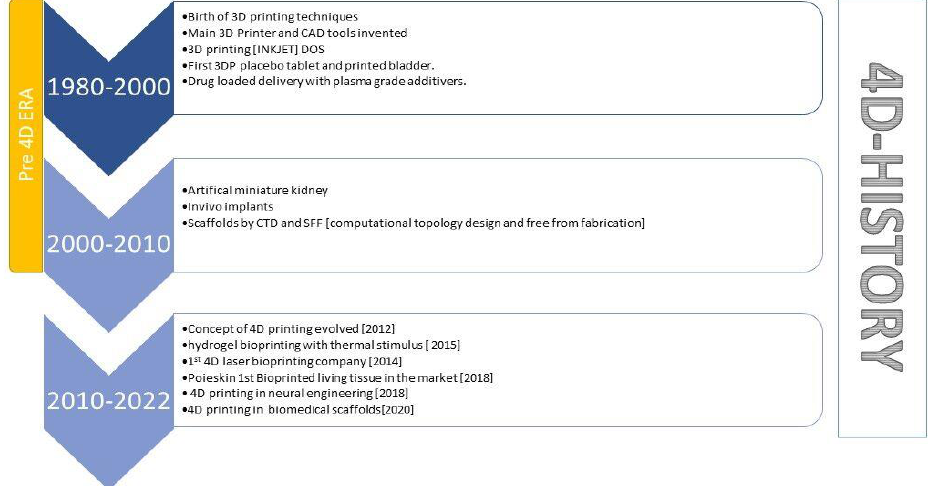
Figure 1. The timeline briefly explains the evolution of 4D printing technology. The timeline is broadly divided into two eras, pre 4D era, which highlights the invention of 3D printing technology. The pre-4D era informs us of the major contribution of 3D printing technology in the healthcare sector and the components and tools used in 3D. The second era is marked by the evolution of 4D printing in 2012, the discovery of various hydrogels and the application of 4D in various sectors.